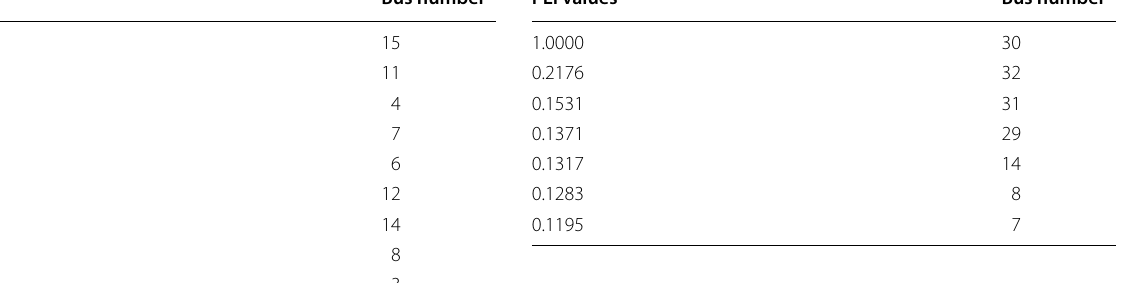
Table 1 PLI values for 15-bus system PLI values Bus number